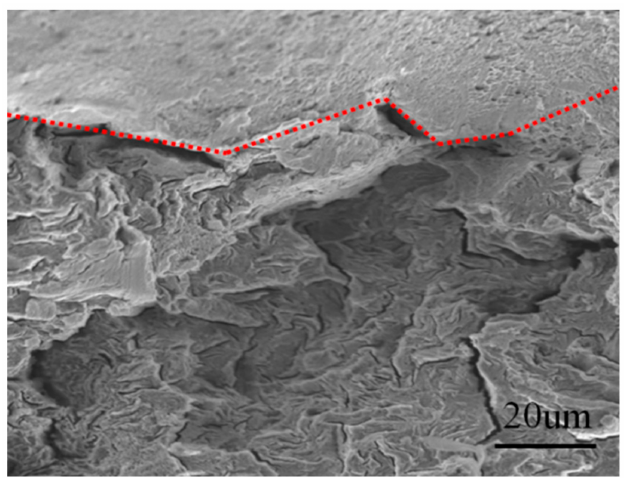
Figure 18. Transition between Mode I and Mode II.